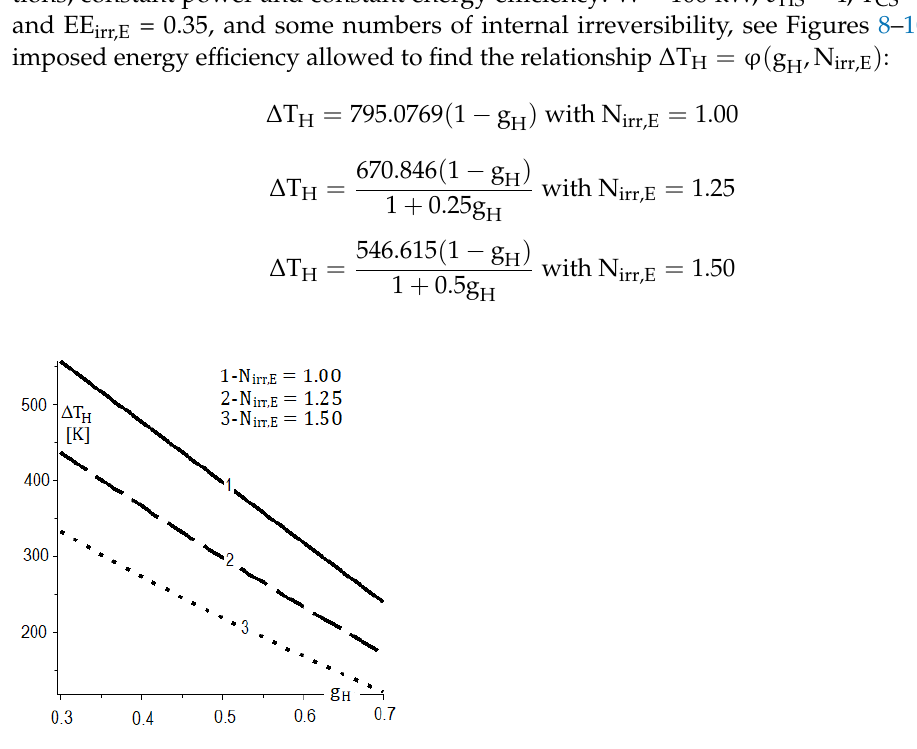
Figure 8. Dependence between the mean log temperature difference at the hot side and the dimen- sionless thermal conductance at the hot side, ∆ T H = f ( g